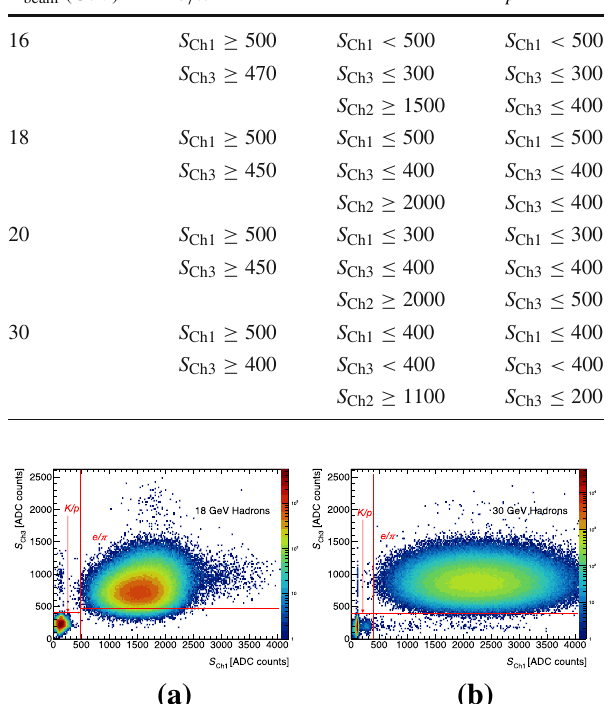
Fig. 6 Scatter plots of the signals measured in the Cherenkov counter Ch3, S Ch3 , in ADC counts as a function of the signals measured in the Cherenkov counter Ch1, S Ch1 , in ADC counts. The histograms were obtained analysing data with beam energies of 18 GeV ( a ) and 30 GeV ( b ). The events were selected applying selection criteria summarized in Table2, uptoSelection3. The cutvalues usedtoselectkaonandproton, K / p , (left/bottom) and electron and pion, e /π , (right/top) events are shown. The color scale indicates the number of events in the bins